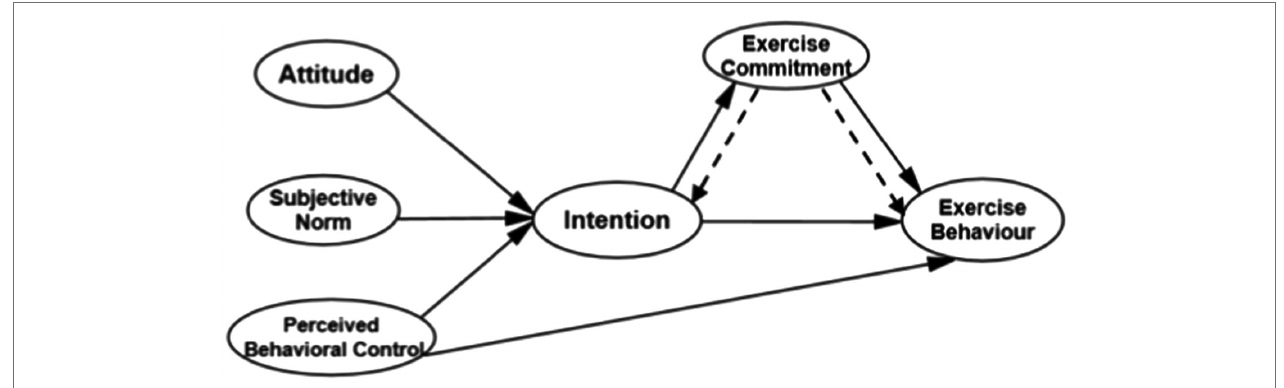
FIGURE 1 | Path coefficient diagram of structural equation model for